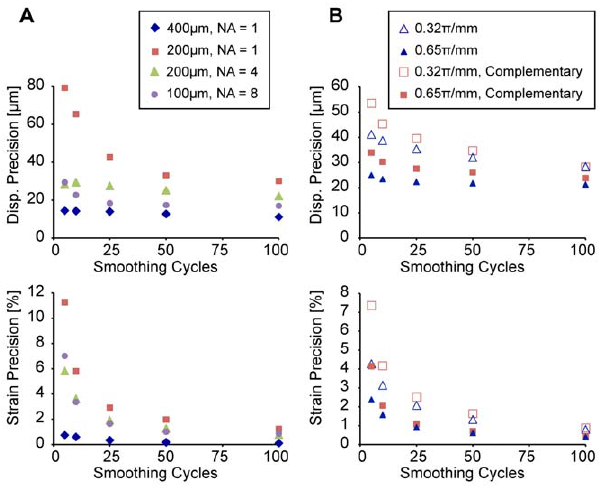
Figure 5. Smoothing of displacements allowed for the computer of strains. Absolute precision of both displacement (top) and strain (bottom) measurements is improved with more smoothing cycles. Across all spatial resolutions ( A ) and gradient moments ( B ), imaging parameters that show better precision in raw displacement data require fewer smoothing cycles before reaching a plateau in the precision of smoothed displacement data.